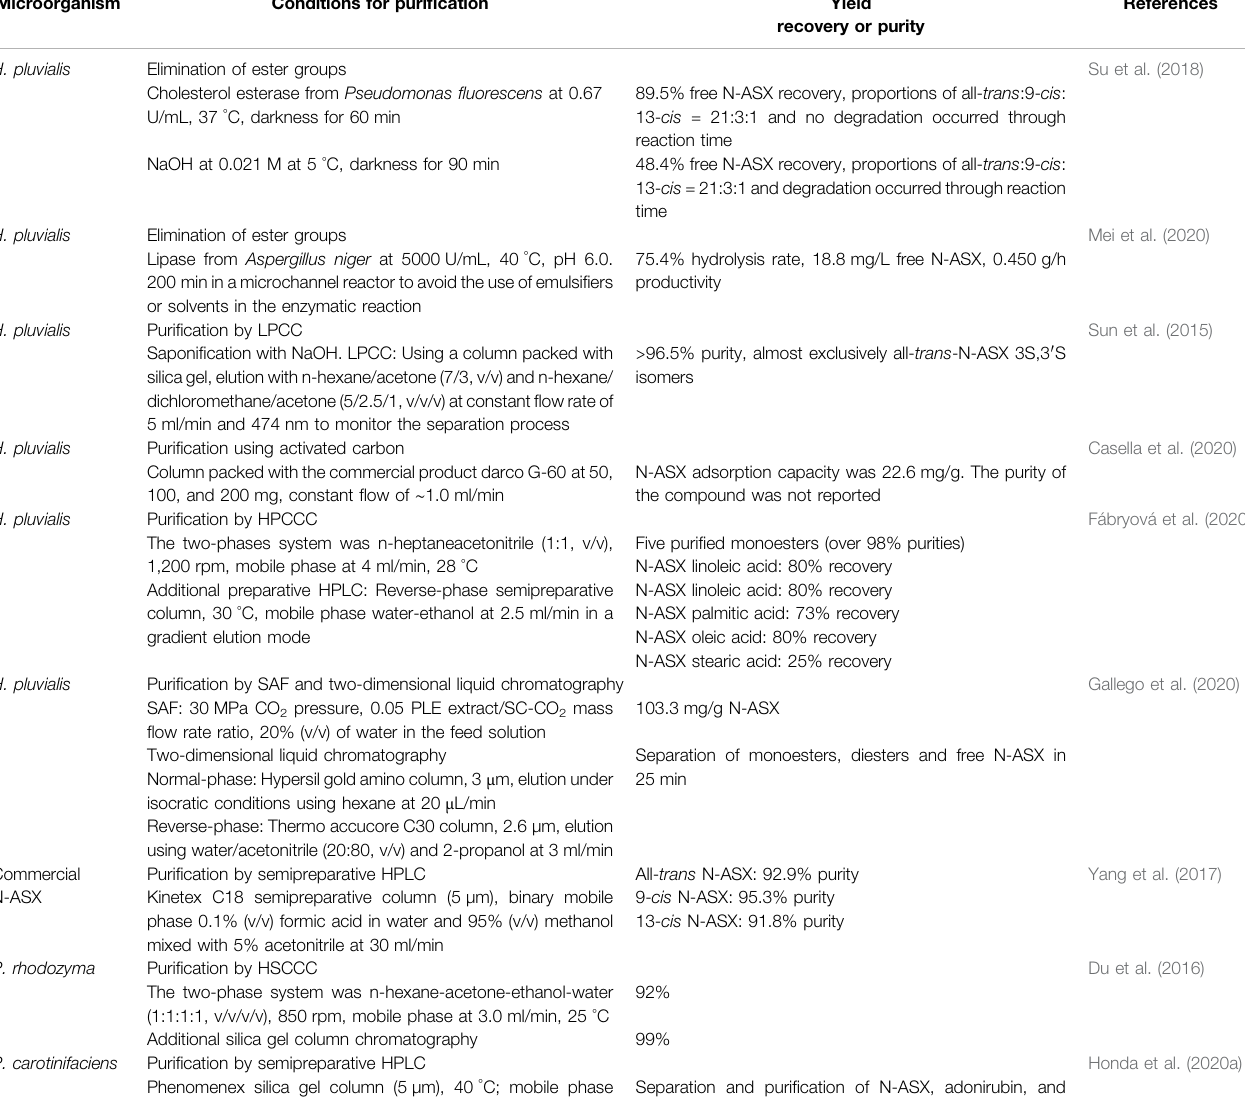
TABLE 5 | Strategies for N-ASX puri fi